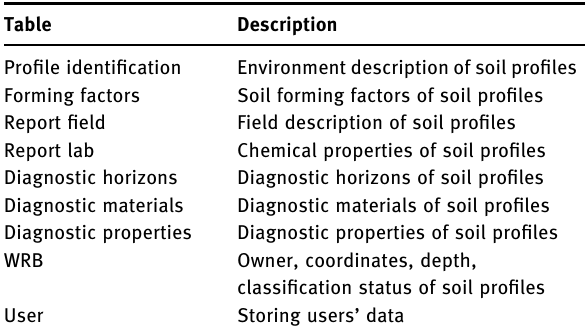
Table 1: Description of database table